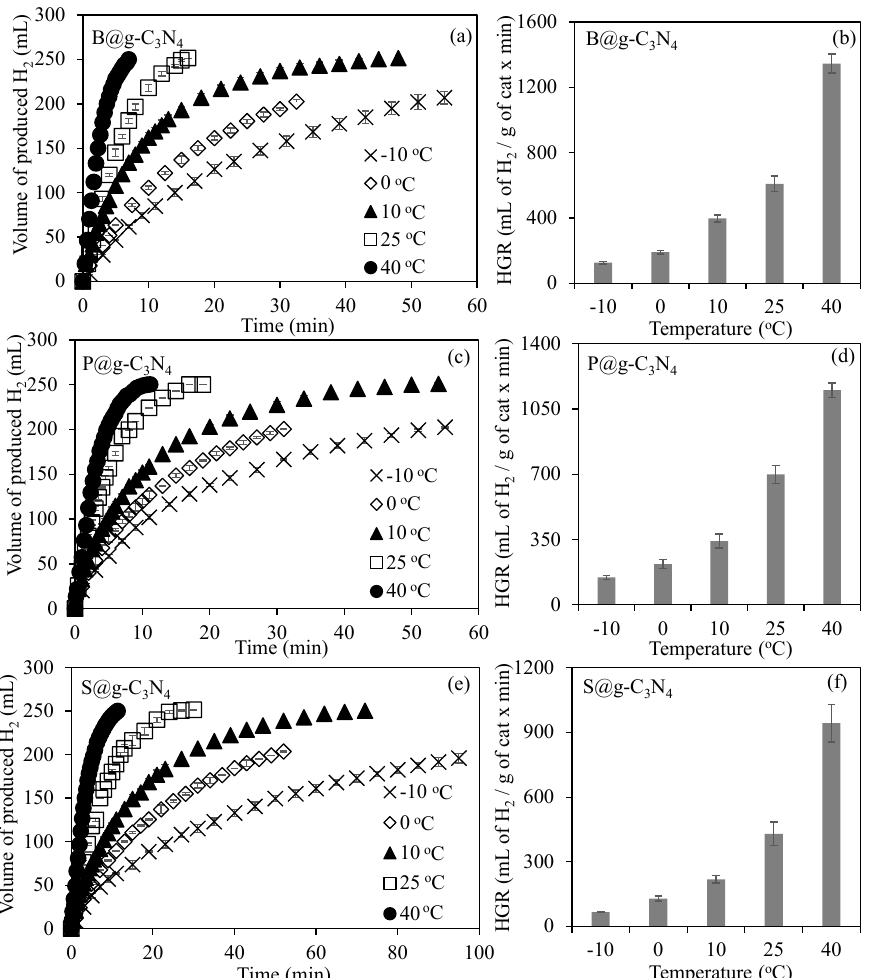
Figure 4. ( a ) The effect of temperature on catalytic activity of B@g-C 3 N 4 , and ( b ) comparison of calculated HGR values for the B@g-C 3 N 4 -catalyzed dehydrogenation reaction of NaBH 4 in methanol, ( c ) the effect of temperature on catalytic activity of P@g-C 3 N 4 , and ( d ) comparison of calculated HGR values for the P@g-C 3 N 4 -catalyzed dehydrogenation reaction of NaBH 4 in methanol, ( e ) the effect of temperature on catalytic activity of S@g-C 3 N 4 , and ( f ) comparison of calculated HGR values for the S@g-C 3 N 4- catalyzed dehydrogenation reaction of NaBH 4 in methanol at various temperatures [reaction condition: 50 mg catalyst, 20 mL methanol, 0.0965 g NaBH 4 , 1000